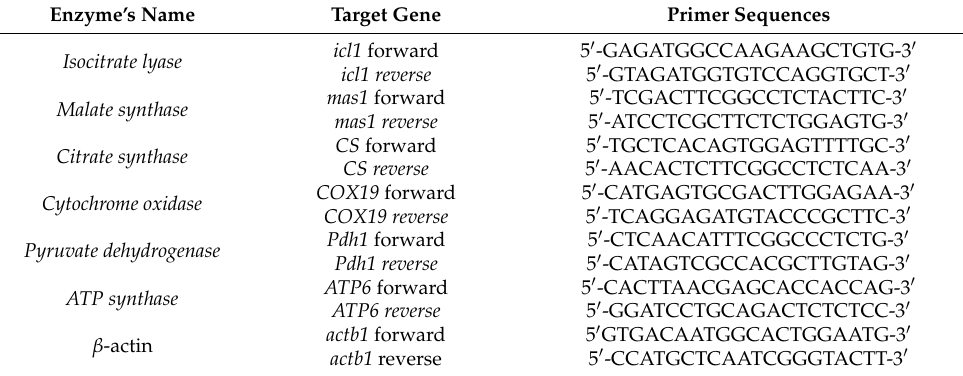
Table 3. Primer sequences of the genes studied for RT-PCR